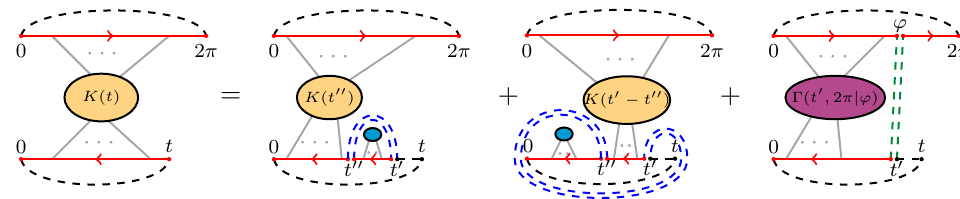
Figure 2 . Diagrammatic representation of Green’s functions.